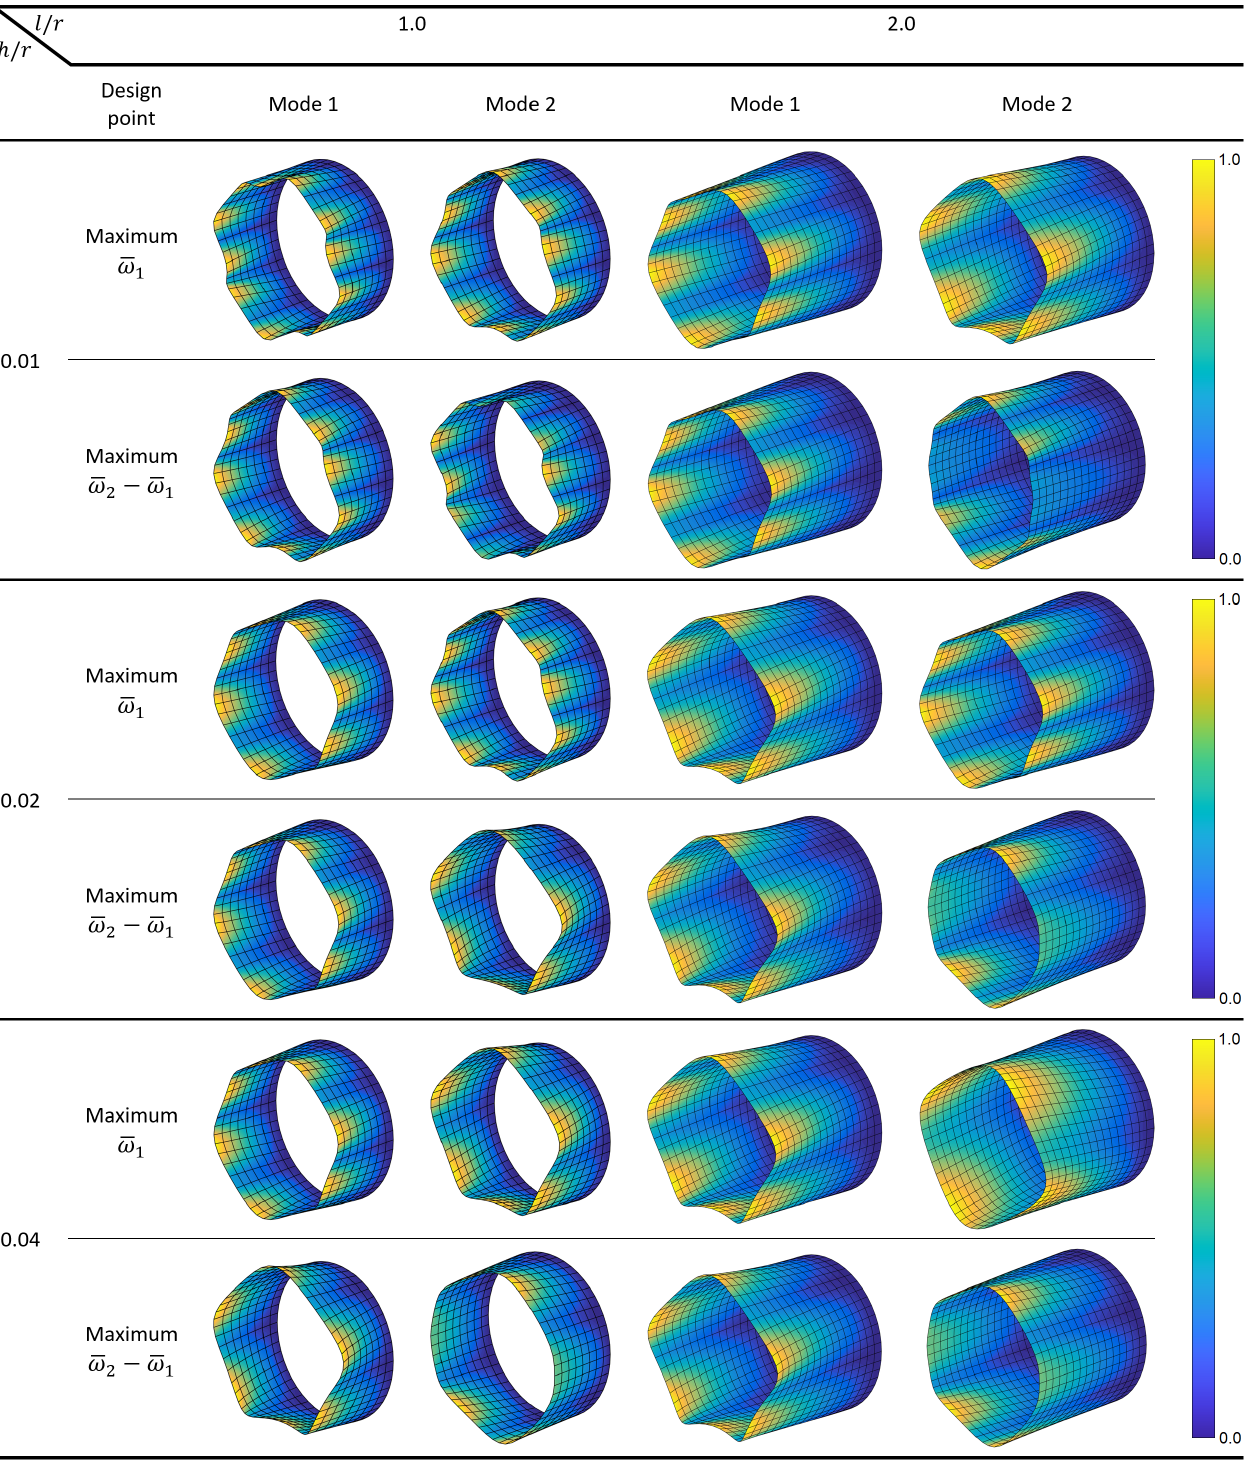
Figure 5. The first two mode shapes of cantilever circular composite cylinders optimized for maximum ω 1 and ω 2 − ω 1